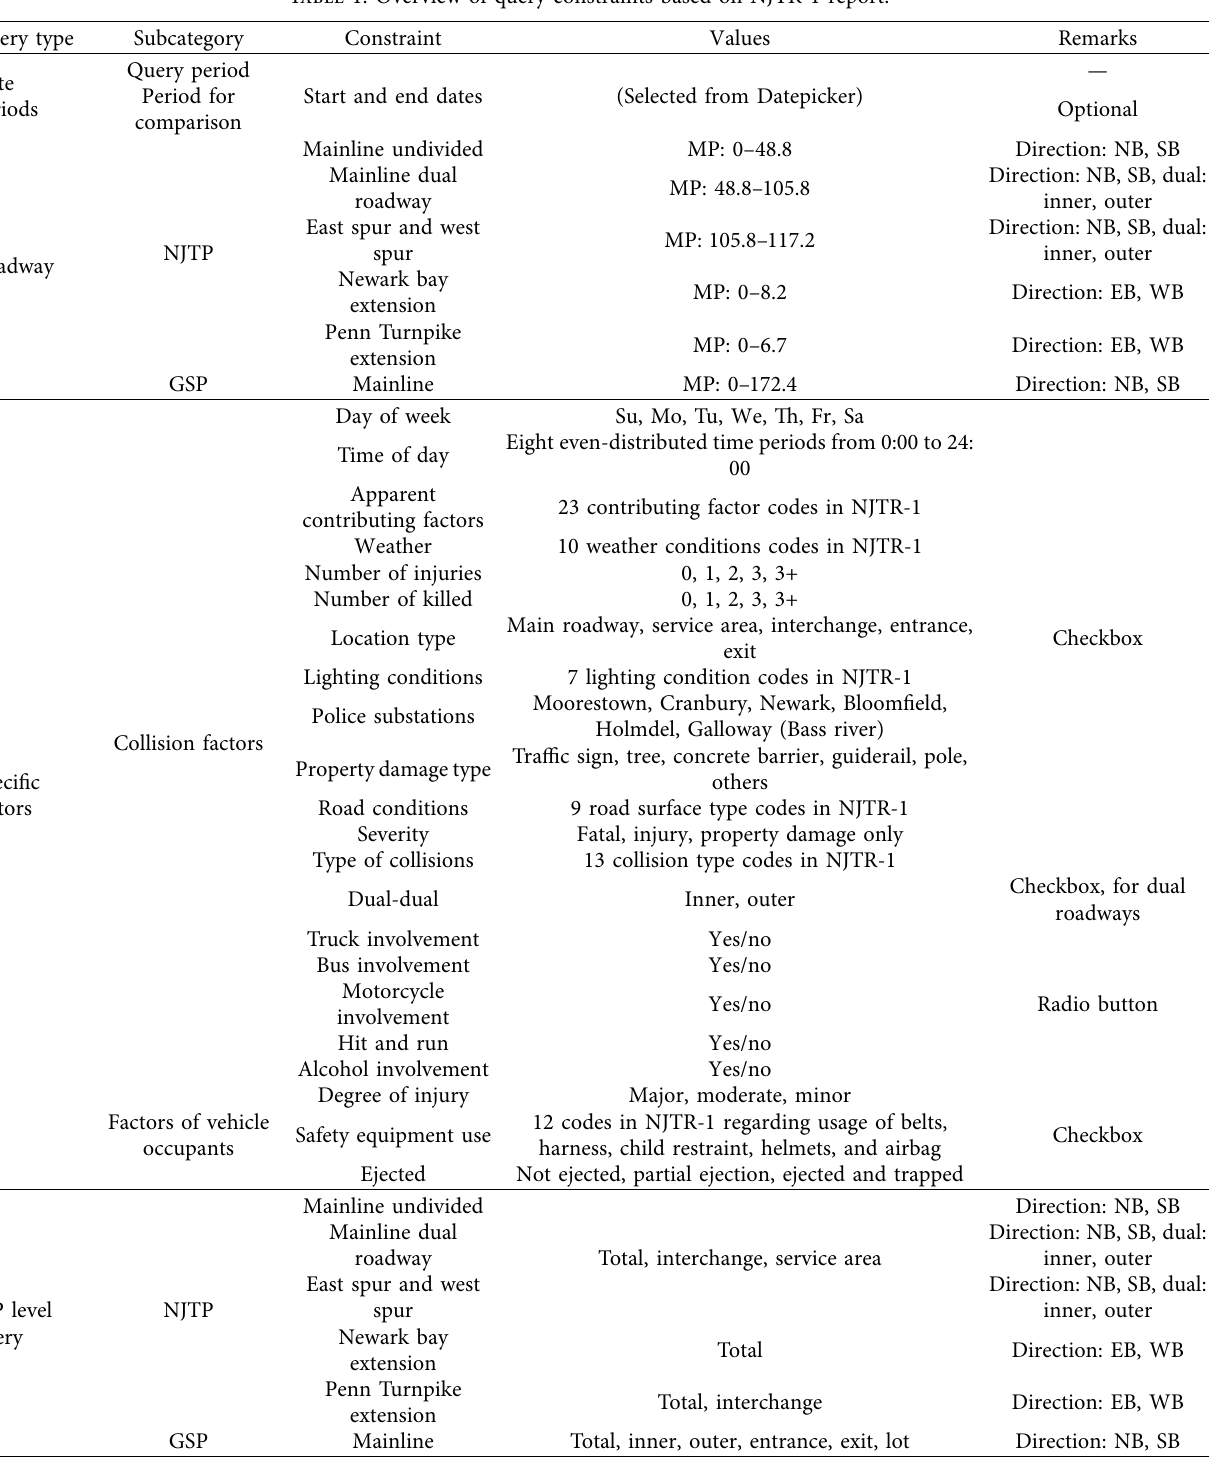
Table 1: Overview of query constraints based on NJTR-1